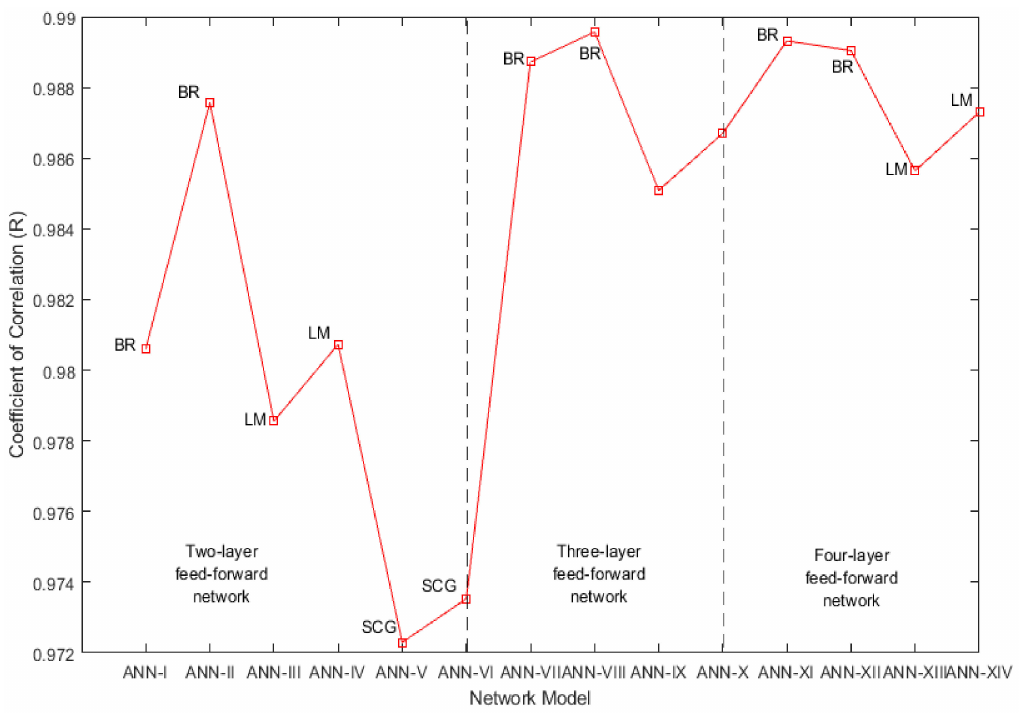
Figure 6. Correlation coefficient comparison of two, three- and four-layer feedforward network